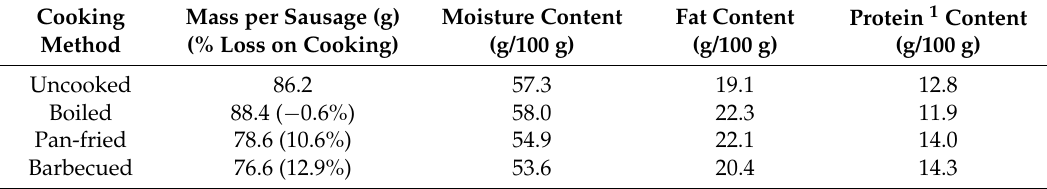
Table 3. Moisture, fat and protein contents of one type of beef sausage cooked by three methods.